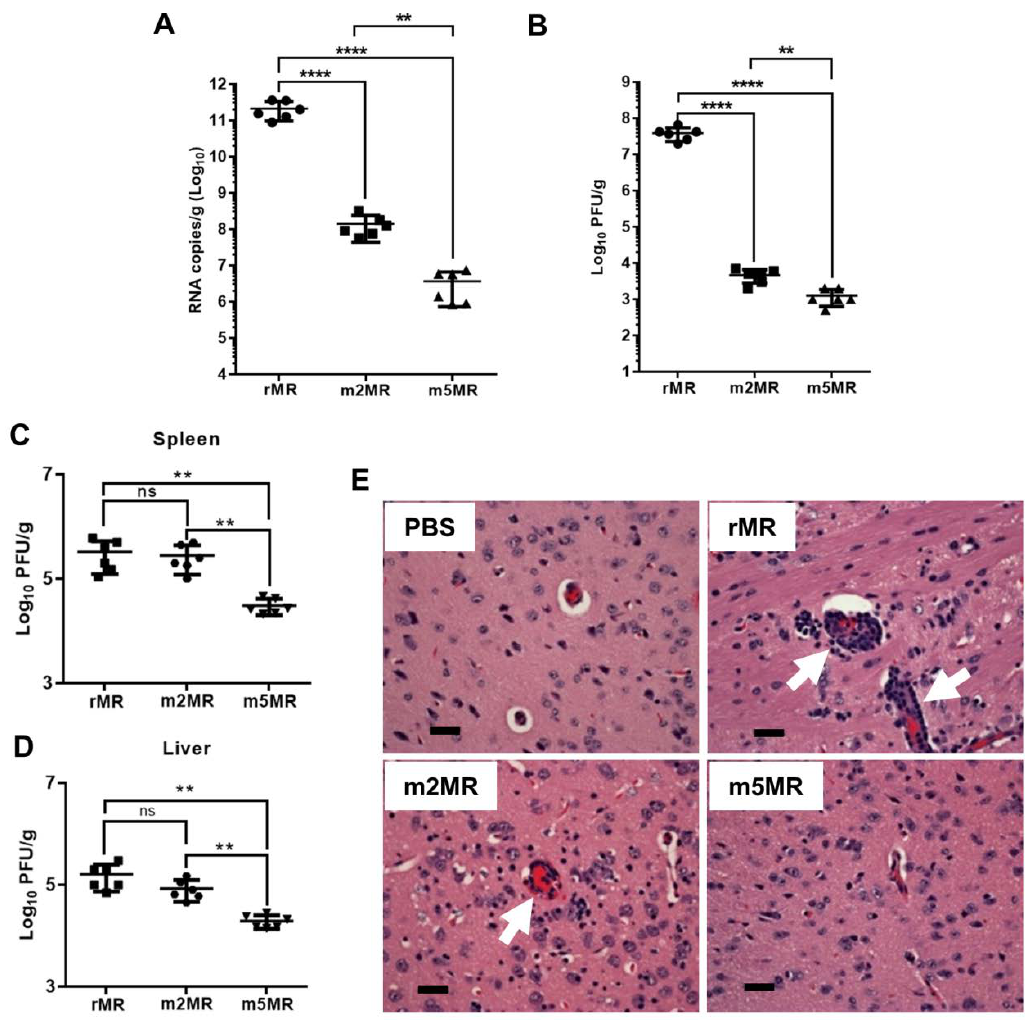
Figure 4. The mutant viruses replicate less efficiently in the brain of infected animals. Viral genome copy number ( A ) and infectious virus titer ( B ) in the brain of animals infected with rMR ( n = 6), m2MR ( n = 6), and m5MR ( n = 6) viruses at 6 dpi. Infectious virus titers from the spleen ( C ) and liver ( D ) of the animals. Unpaired Student’s t -test (two-tailed) was used to determine significance between the groups. ****, p < 0.0001; **, p < 0.01. ( E ) Hematoxylin and eosin staining of sections of the cerebrum of animals inoculated with PBS, or infected with rMR, m2MR, or m5MR viruses. Representative images of the cerebrum (40x) from animals in each group are shown. Prominent perivascular cuffing in rMR- and m2MR-infected samples are shown with white arrows. Scale bar (at bottom left), 60 μm.